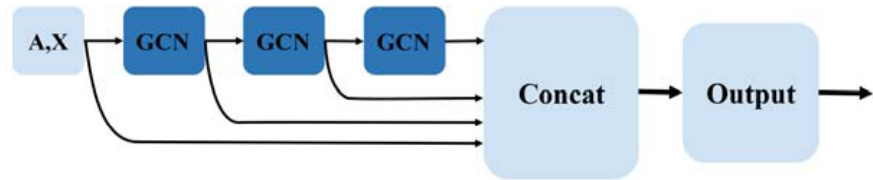
Figure 2. Three-layer graph convolutional layer structure of HLGNN-MDA.